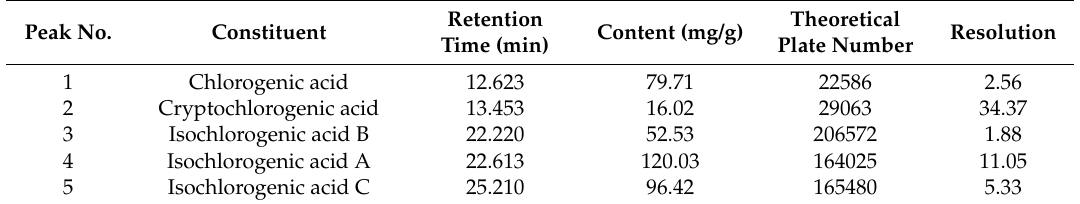
Figure 1. Determination of KTP constituents by HPLC. ( A ) Standard chromatograms; ( B ) KTP chromatograms (one sample). 1: chlorogenic acid; 2: cryptochlorogenic acid; 3: isochlorogenic acid B; Table 1. Determination of KTP constituents by HPLC (one